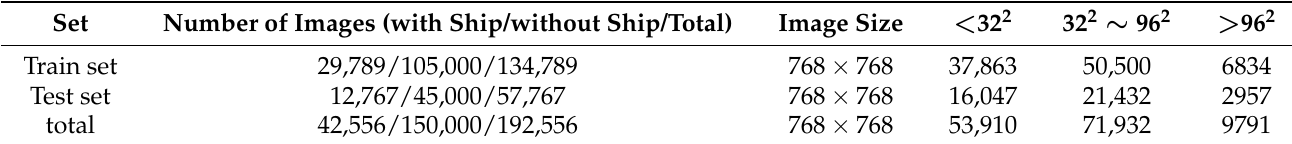
Table 1. Airbus ship dataset.